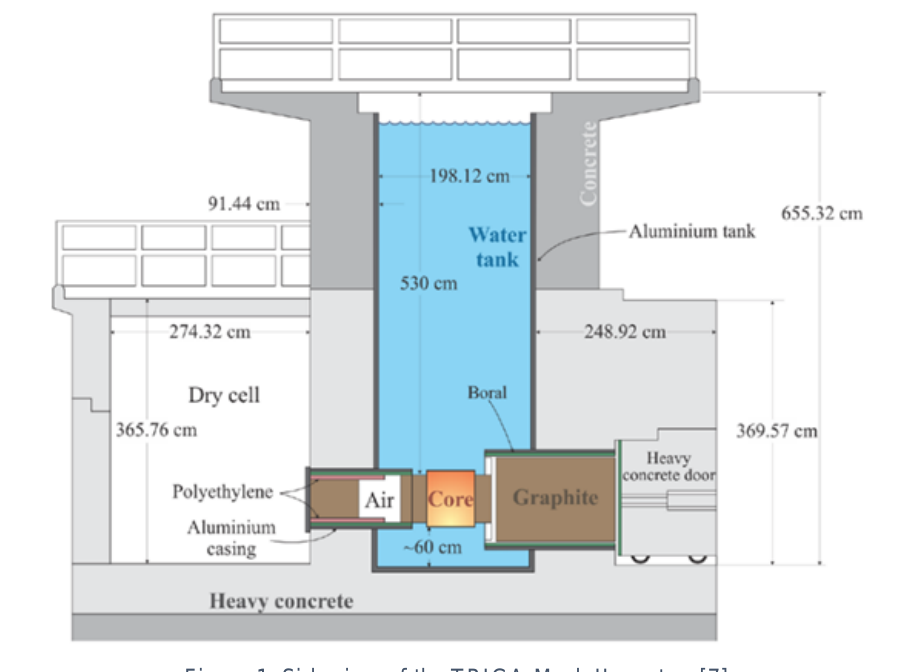
Figure 1: Side view of the TRIGA Mark II reactor. [7]